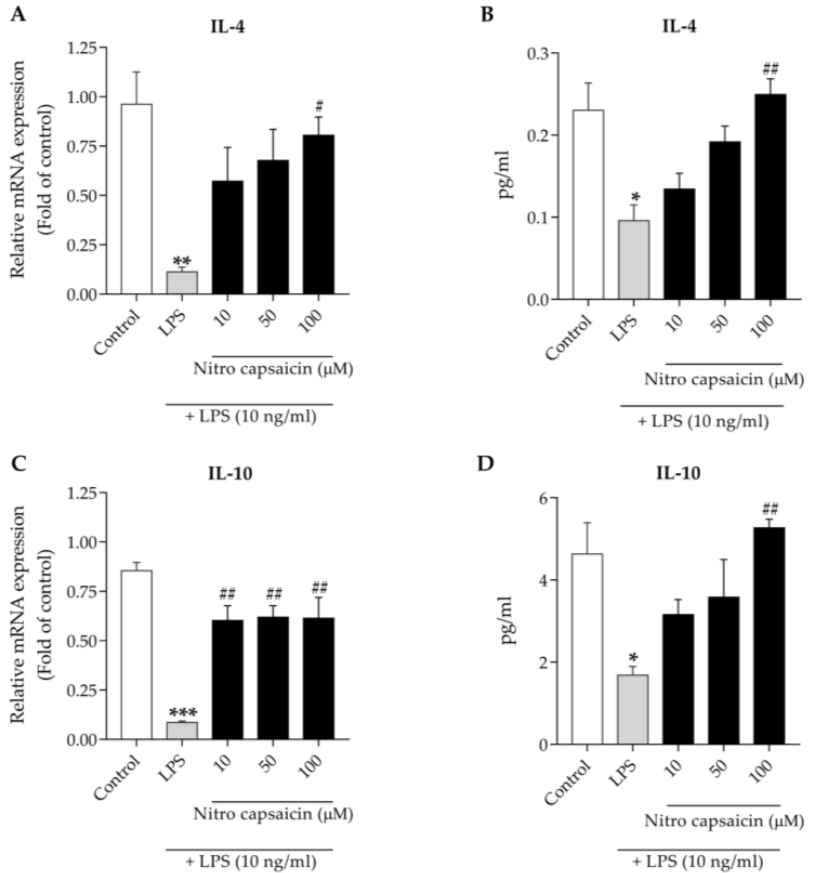
Figure 4. Effects of nitro capsaicin against LPS-suppressed anti-inflammatory cytokine production in SIMA9 cells. Nitro capsaicin increased mRNA expression of ( A ) IL-4 and ( C ) IL-10. Nitro capsaicin enhanced release of the cytokines ( B ) IL-4 and ( D ) IL-10. The control was DMSO treatment. * p < 0.05, ** p < 0.01, and *** p < 0.001 versus control group; # p < 0.05 and ## p < 0.01 versus LPS-treated group.